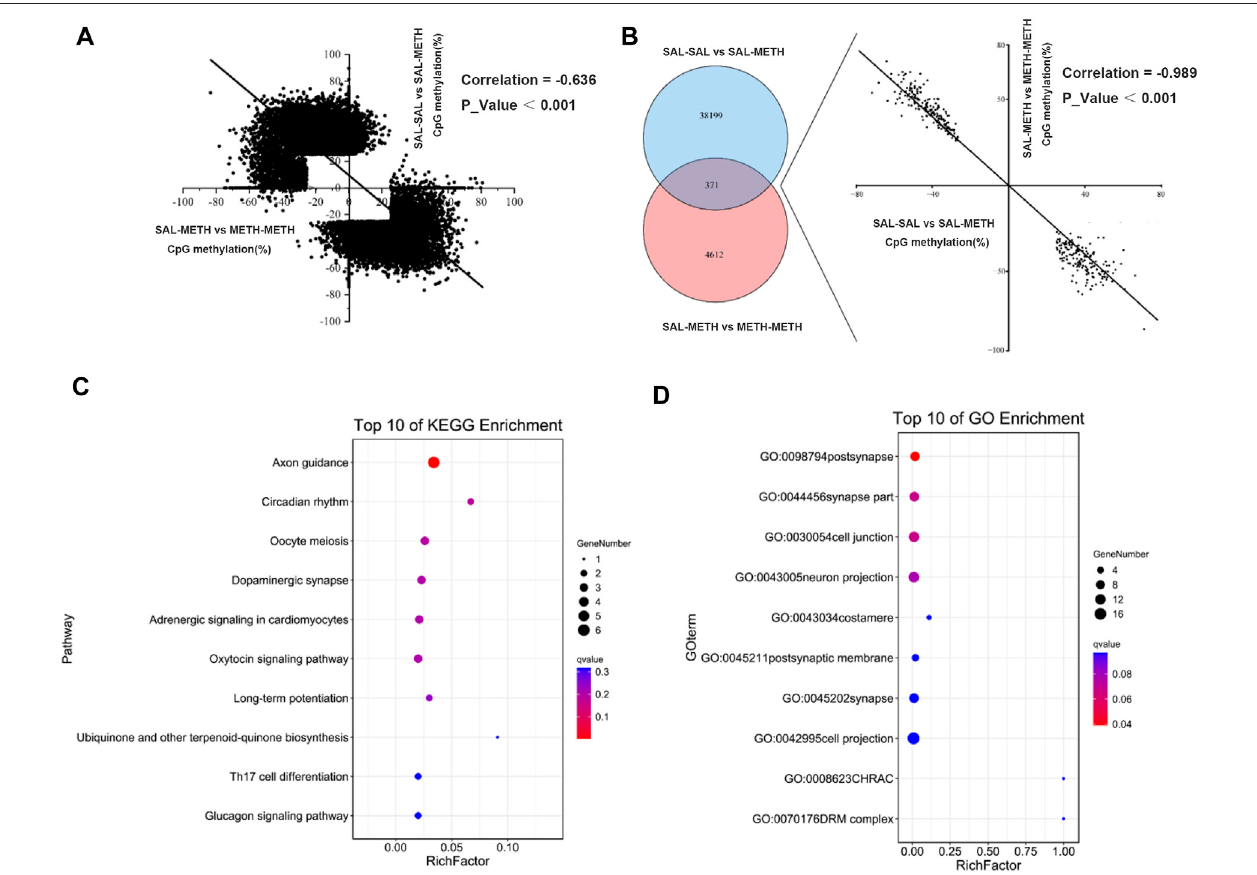
FIGURE 5 | Venn diagram depicting the number of CpGs that are uniquely and commonly affected between postnatal METH exposure and pre- and postnatal METH exposure comparison group. (A) A negative correlation of DMCs between postnatal METH exposure and pre- and postnatal METH exposure comparison group. (B) 371commonly methylated CpGs(co-methylated) affectedbypostnatal and pre- and postnatal METHtreatments and show asigni fi cantnegative correlation. (C) Top 10 pathway enrichment results of co-methylated CpG localized genes. (D) Top 10 cellular components of GO enrichment results of co-methylated CpG localized genes. Hypergeometric distribution test was used. Data in each group are based on n =